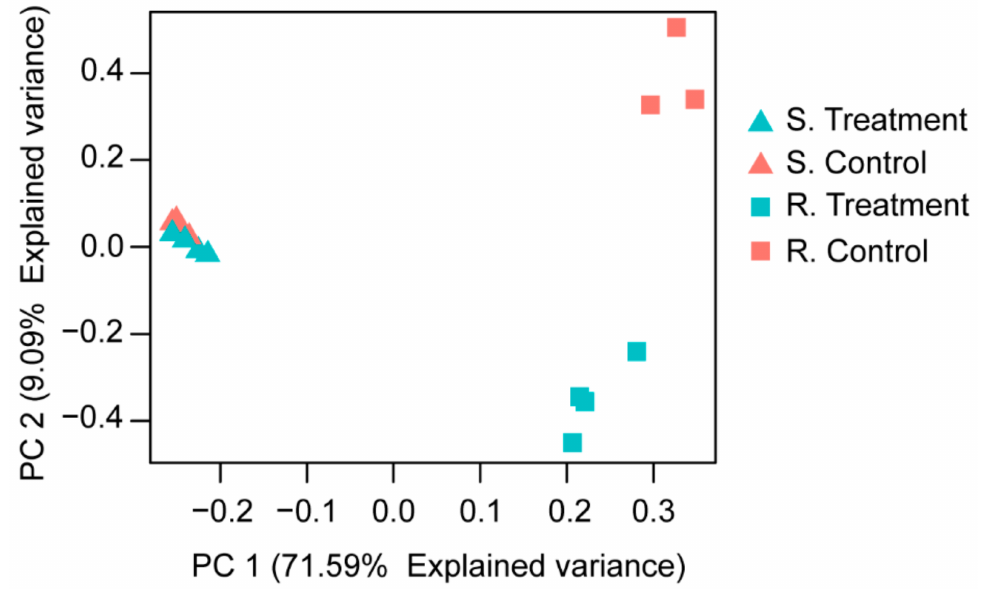
Figure 3. Principal Component Analysis of Imperata cylindrica in shoots and roots samples. The control treatment was established without Cu addition, while the treatment consisted in the addition of 300 mg Cu kg − 1